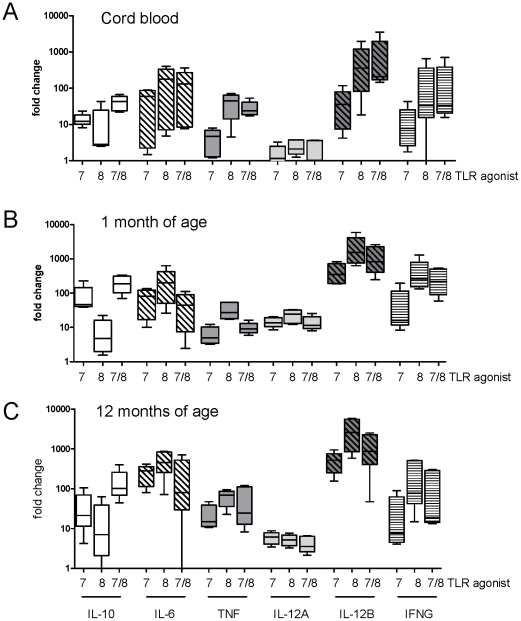
TLR7- and TLR8-mediated cytokine mRNA expression varies between
agonists and across the first year of life.300 µl of whole blood was cultured for 4 hours with
Gardiquimod™ (TLR7), ssRNA (TLR8 agonist) and CL075 (TLR7/8) at
(A) birth, (B) 1 month and (C) 12 months of age. RNA was purified and
cytokine mRNA was quantified by real time PCR as described in Materials and Methods. Ct values were
normalised against the housekeeping genes and compared to the
unstimulated control (ΔCt) and fold differences of ΔCt values
between unstimulated and stimulated cultures were calculated
(ΔΔCt). Fold changes are presented as box and whisker plots,
n = 5.